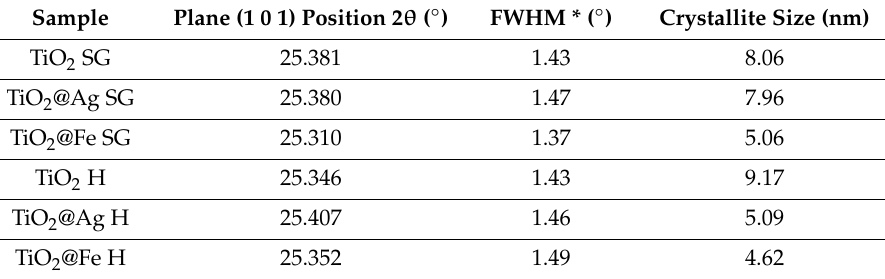
FWHM * full width at half